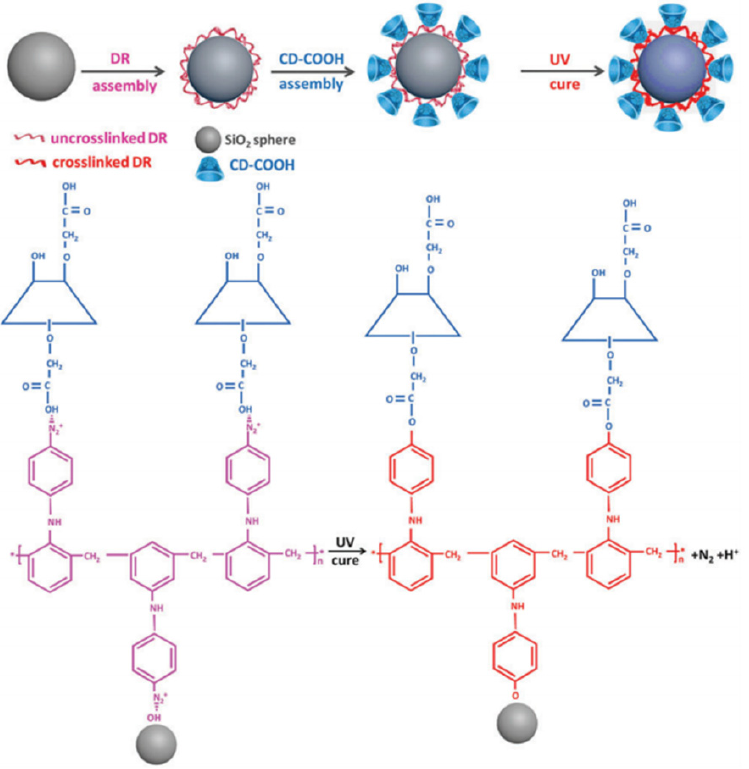
Figure 7. Light-assisted preparation of a cyclodextrin-based chiral stationary phase (reprinted from Publication Tang, Q.; Yu, B.; Gao, L.; Cong, H.; Zhang, S., Light-assisted preparation of cyclodextrin- based chiral stationary phase and its separation performance in liquid chromatography. New J. Chem . 2017, 42, (2), 1115–1120. Copyright © 2018, with permission from Royal Society of Chemistry [90]).